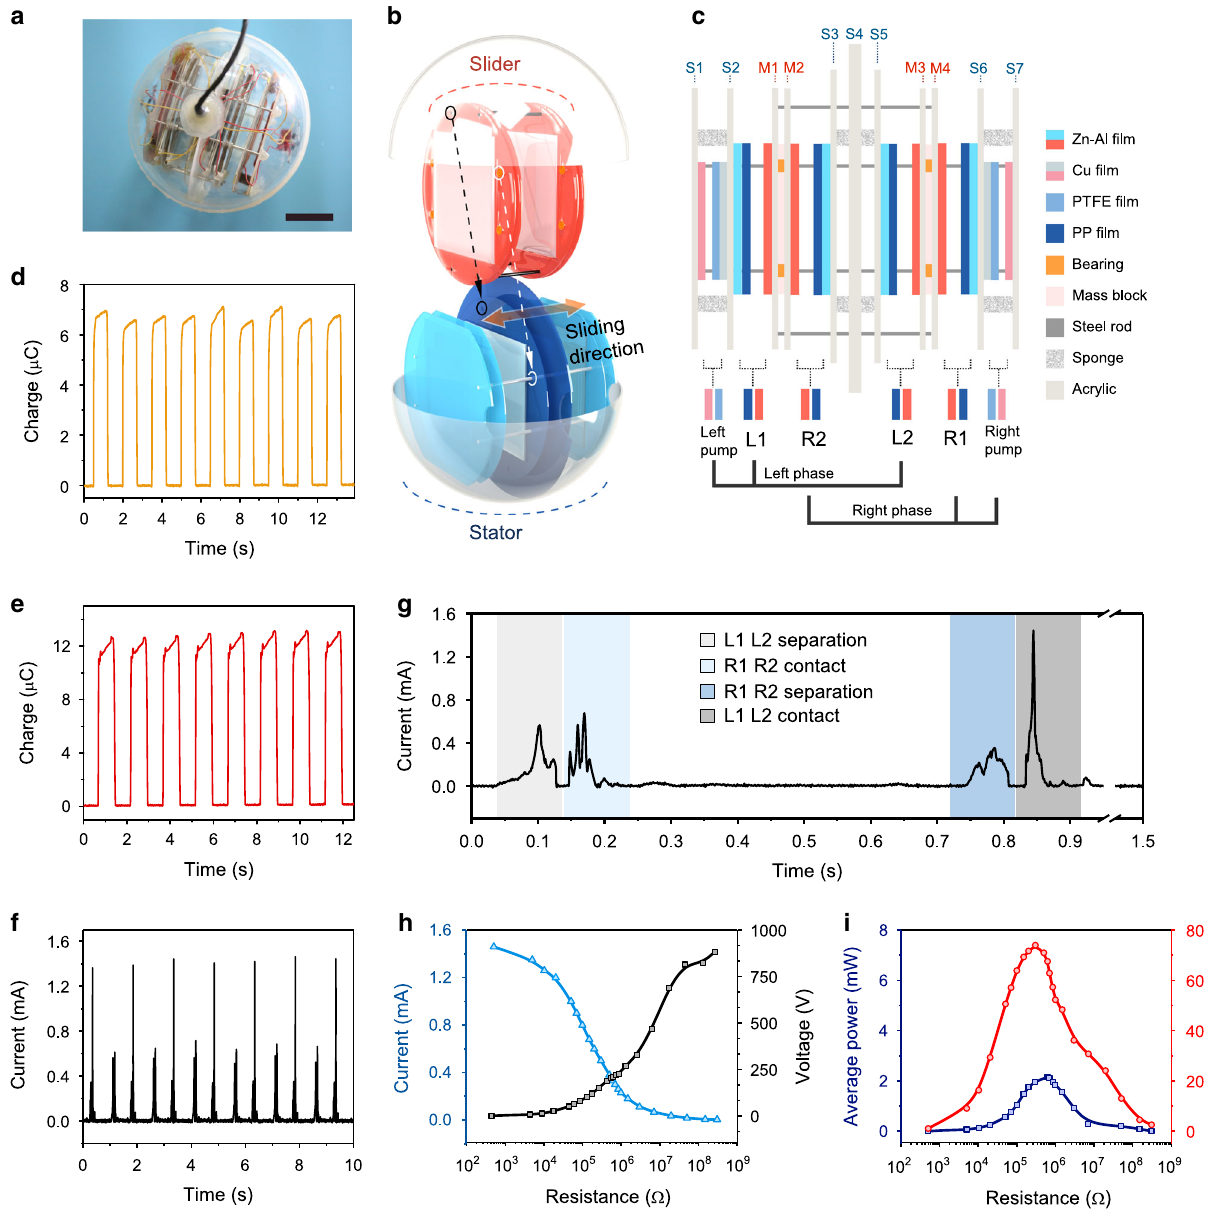
Fig. 4 Structure of the integrated device and electrical measurements in air. a Photograph of the integrated device based on the CS-TENG. Scale bar, 5 cm. b Schematic explosive view of the integrated device. c Schematic side view of the integrated device without the package shell. d , e Shuttled charges of the main TENG L1 ( d ) and main TENGs L1, L2 ( e ) pumped by the left pump TENG. f Total output current of four main TENGs in the integrated device. g Detailed output current curve extracted from f . h , i Peak current and load voltage ( h ), peak power and average power ( i ) of the integrated device with various loads. The agitation frequency is 0.67 Hz. Source data are provided as a Source Data fi 12,37 . The peak current and load vol- the current due to I ¼ dQ dt tage under various resistances were also tested, as shown in Fig. 4h. The peak current decreases gradually with the rising resistance, while the voltage increases. The corresponding power output is demonstrated in Fig. 4i. A maximum peak power of 74 mW is achieved at 300 k Ω , and the highest average power reaches 2.16 mW. Compared with that of a single CS-TENG, the decrease of maximum peak power can be ascribed to the changed driving condition for each TENG due to the indirect agitation in the integrated device, where the contact and separation speed of TENGs affects the value of current peaks and corresponding power output 12,37 .